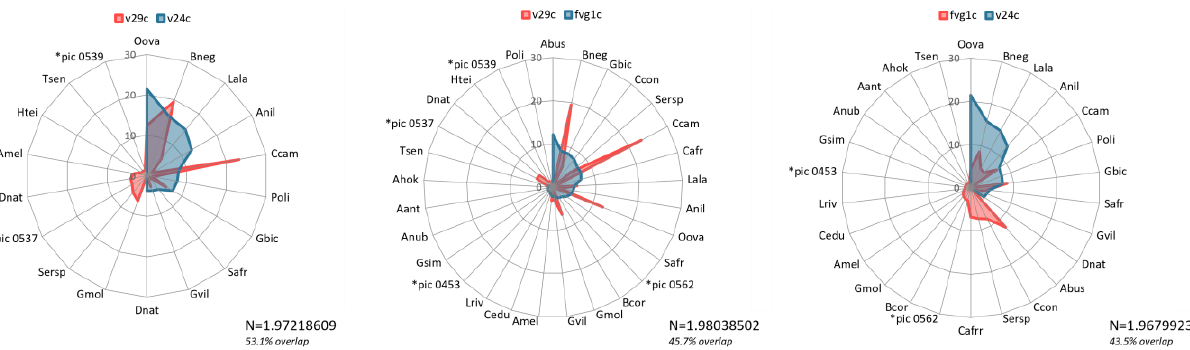
Figure 10. Paired comparisons of vegetation species’ compositions for classification classes that returned an ROI separability metric between N = 1.9 and N = 1.98 in order from the highest case of species’ overlap. These class community comparisons show common species occurring between them, in varying quantities and differences in positions of the contributive dominant species. See Appendix Table A1 for abbreviated species’ names meaning. Unknown species were assigned labels starting with *pic and are shown in figure A1.